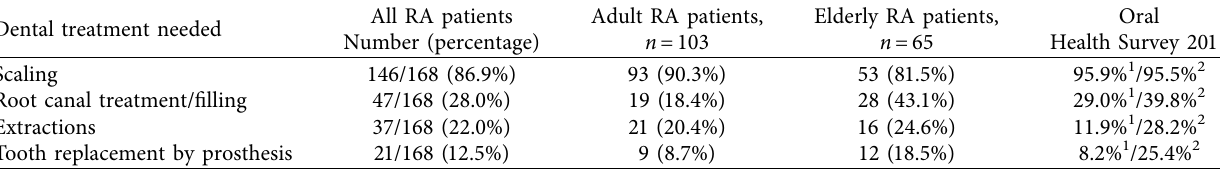
Table 3: Assessed dental treatment needs in rheumatoid arthritis patients and age-matched community subjects. Dental treatment